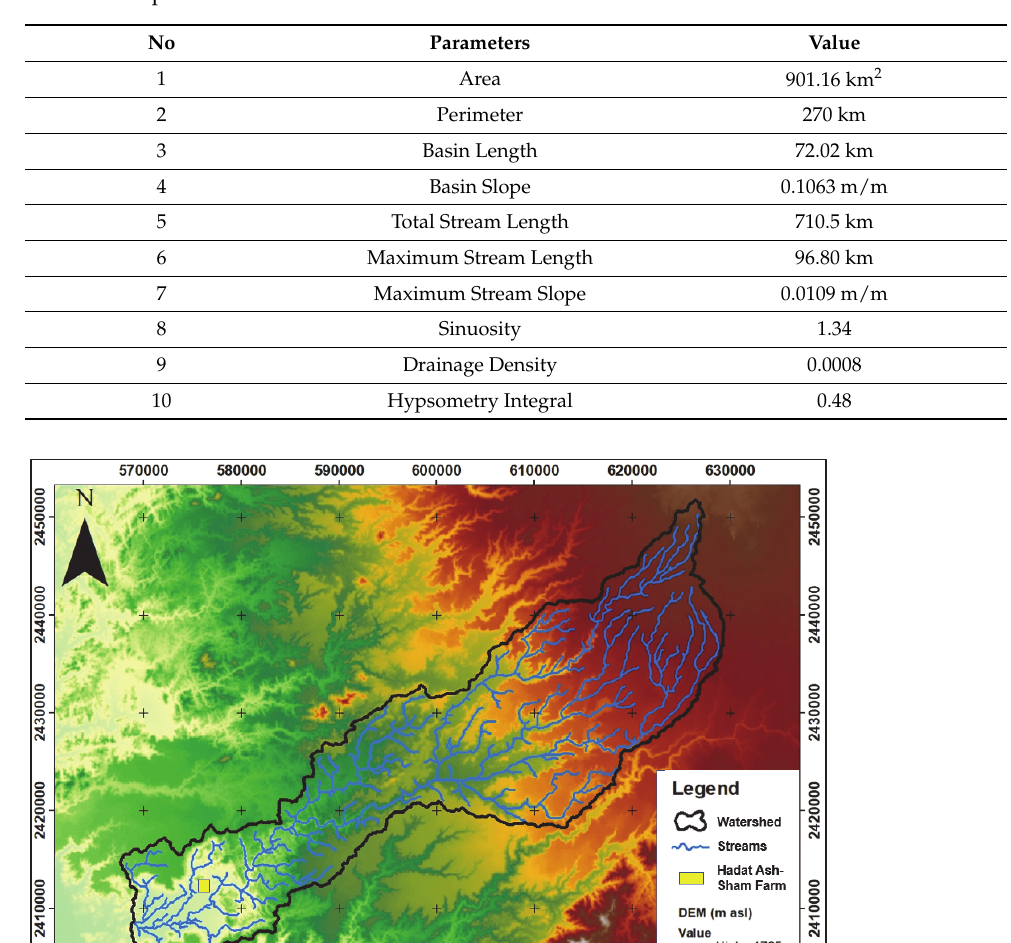
Figure 1. Schemes follow the same formatting. Table 1. Morphometric information of Al-Lusub watershed.